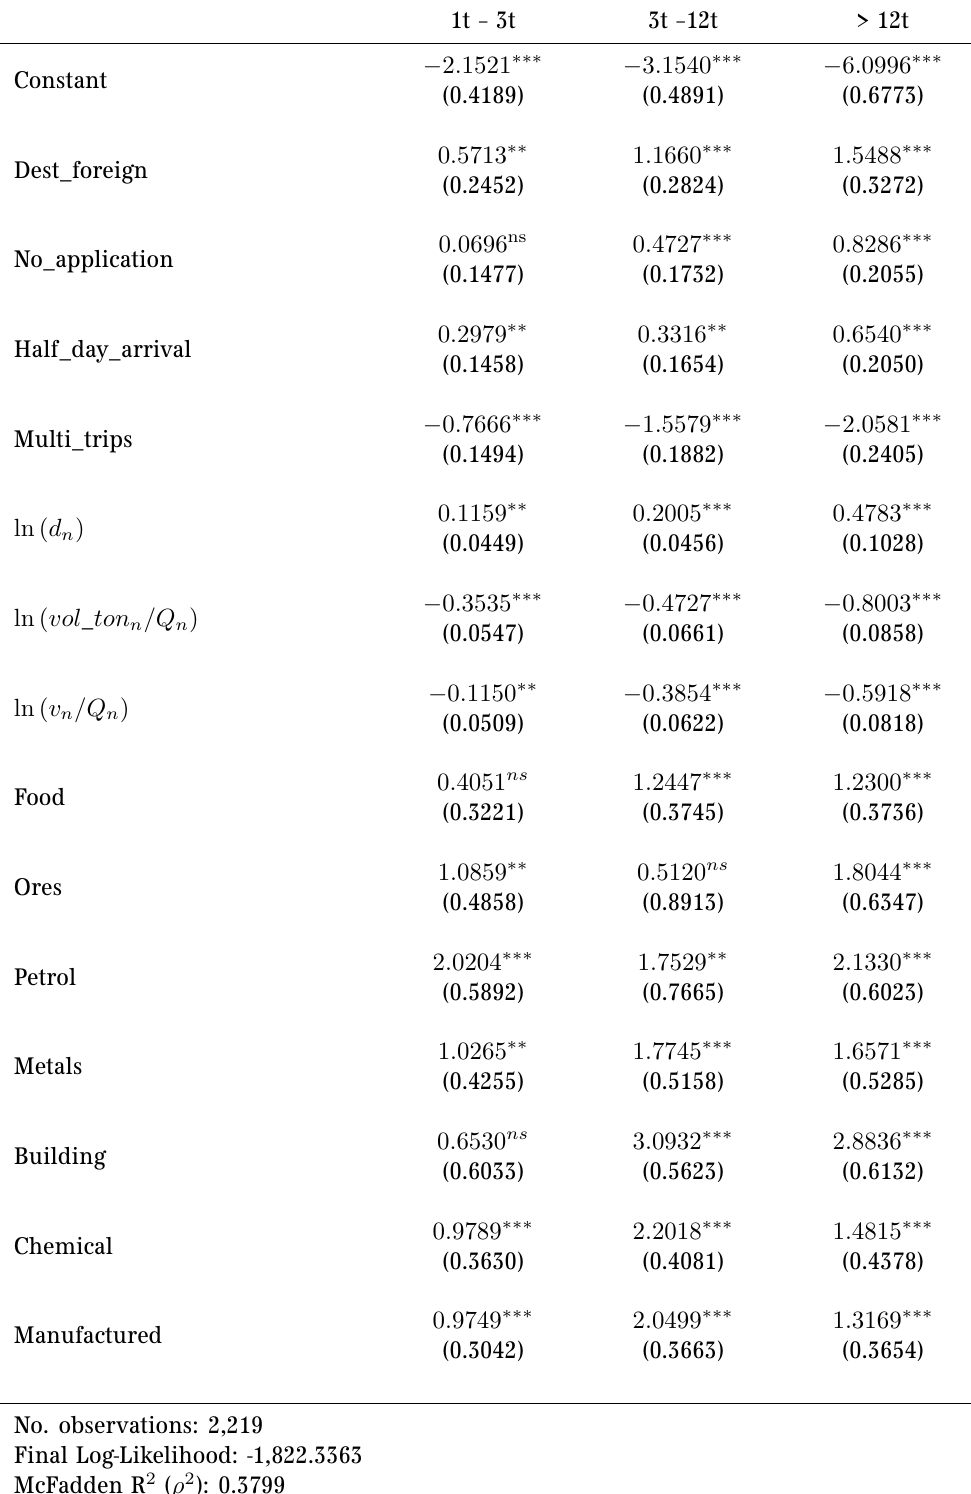
Table 13: Discrete shipment size choice model with NST/R